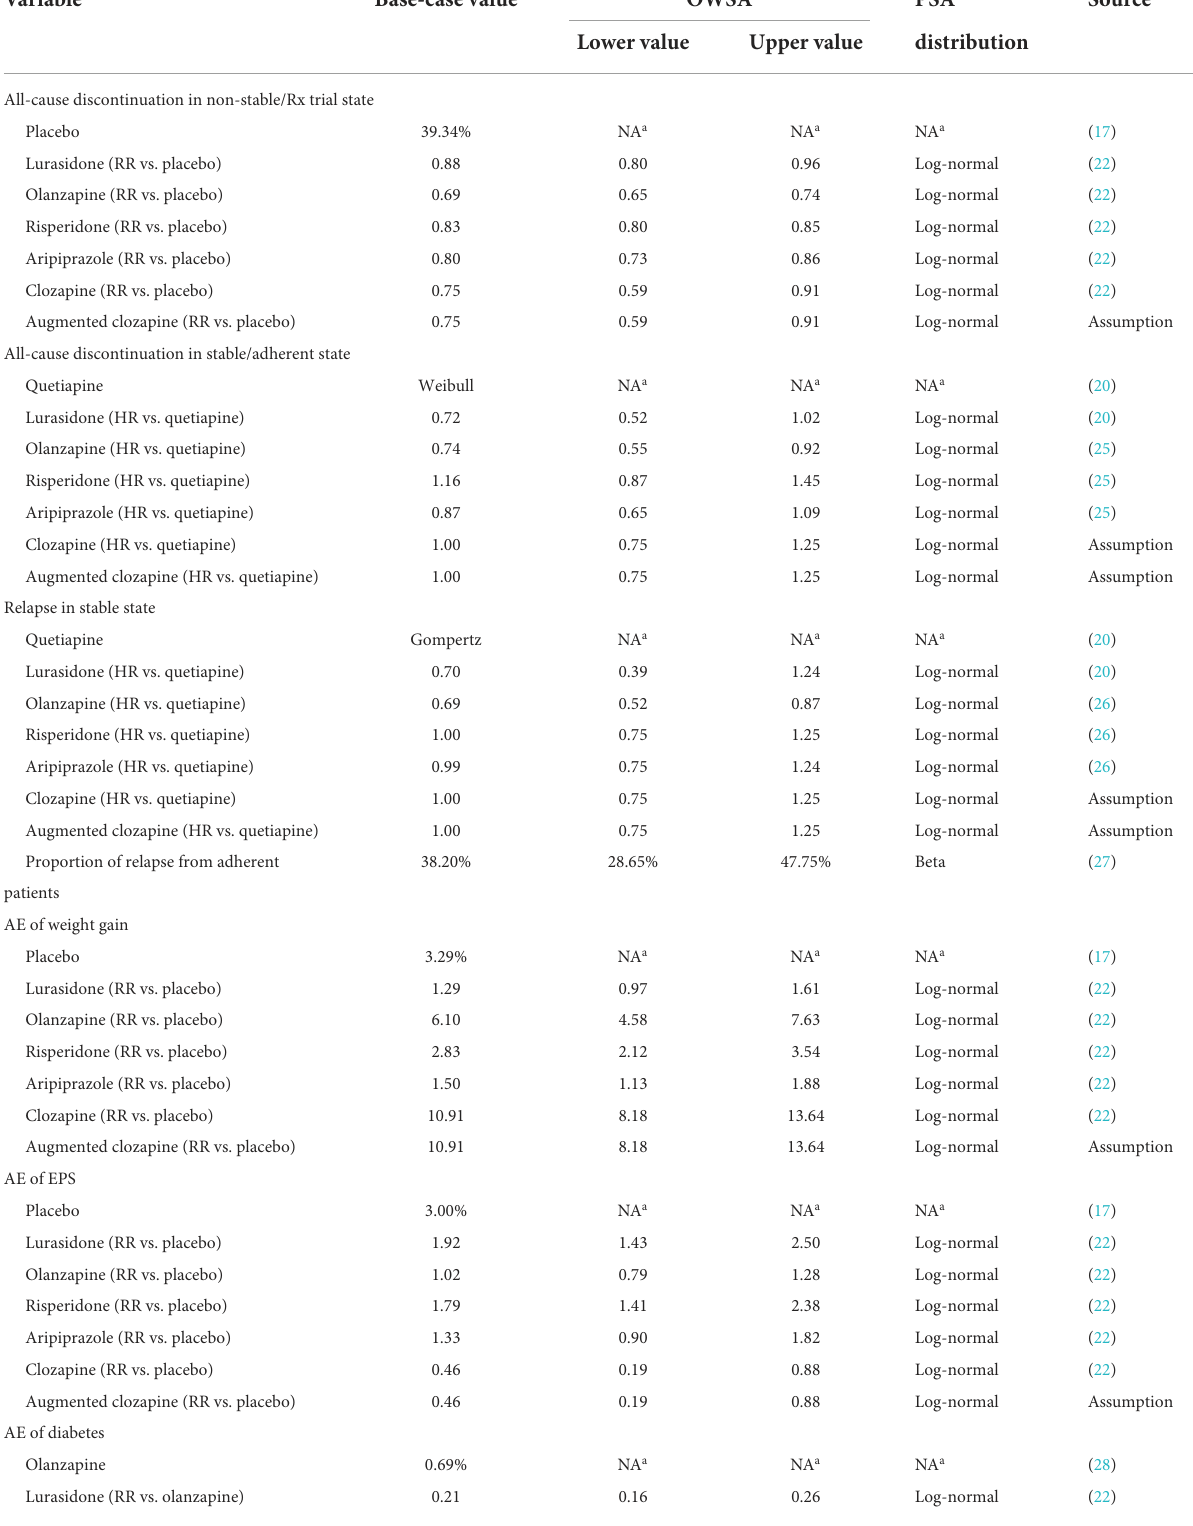
TABLE 1 Summary of clinical data used in the model.